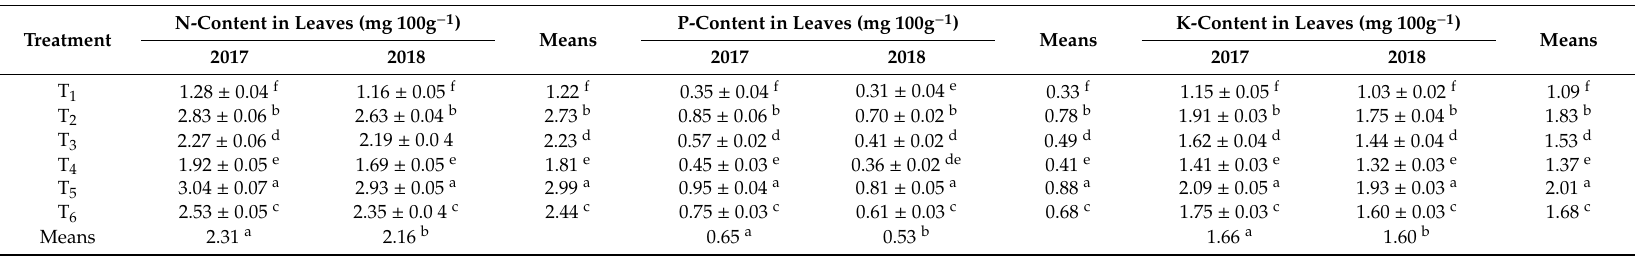
Table 6. E ff ect of organic, inorganic, and biofertilizers on compositional variables (N-Content, P-Content, and K-Content) of Jew’s mallow ( Corchorus olitorius L.) plants.